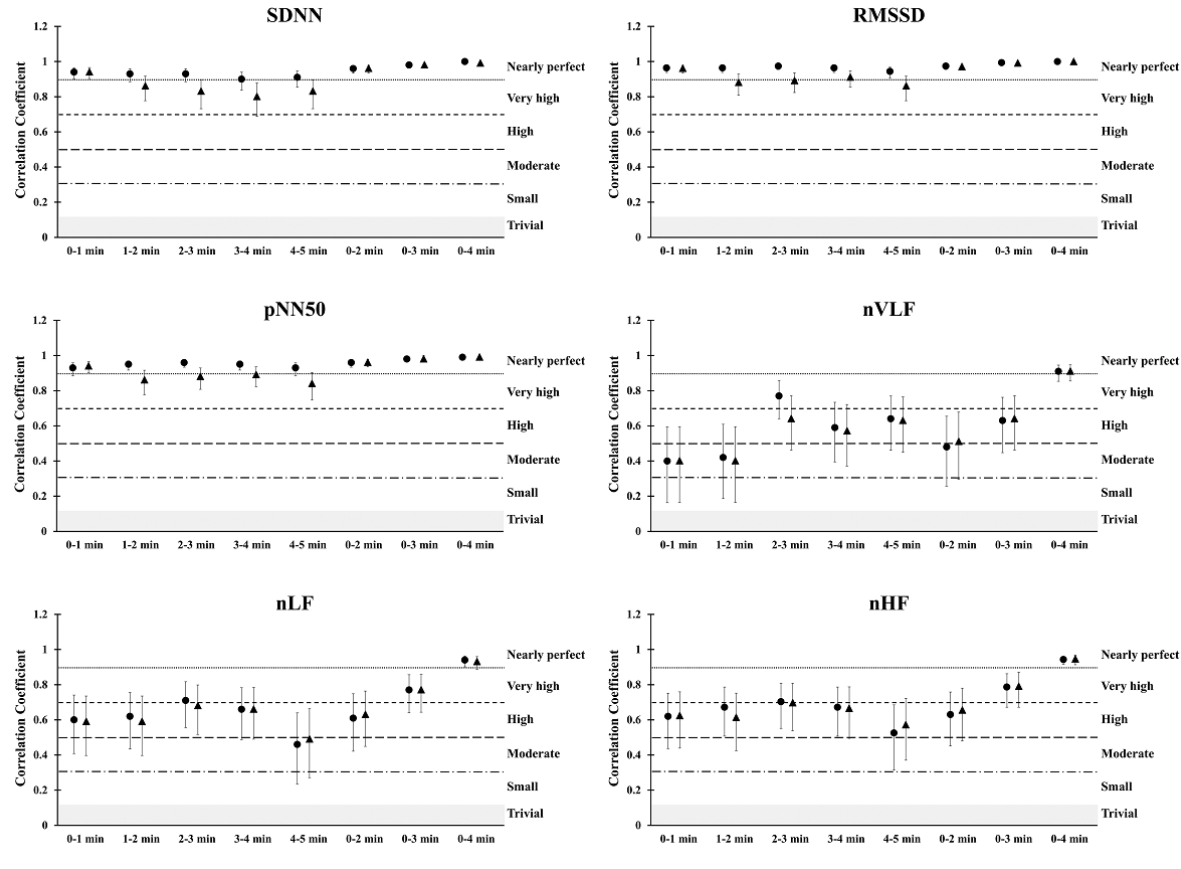
Figure 3. Spearmen correlation coefficients between the ECG and Pulse Express PRO measurements in ultra–short-term and short-term heart rate variability in time-domain and frequency-domain analyses. The grey area indicates trivial correlation coefficient values. The black circle indicates the ECG recordings, while the black triangle indicates the Pulse Express PRO recordings. ECG: